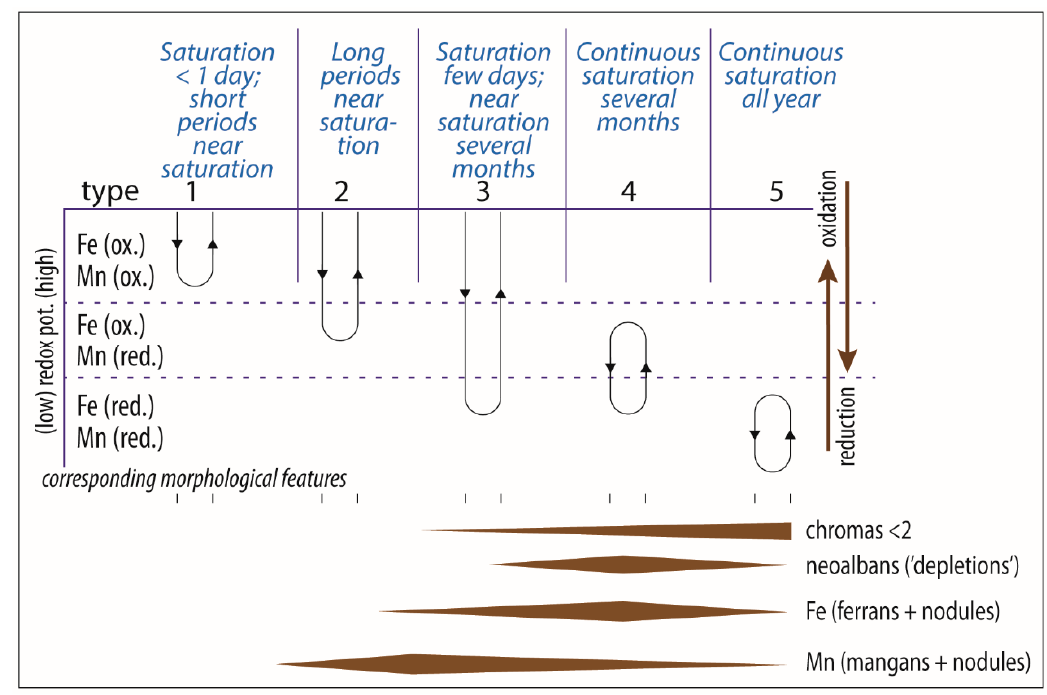
Figure 9. Schematic diagram of approximate soil-moisture redox conditions (potential) and resulting redox (or redoximorphic) features and different associated soil types designated 1–5. The Kainui soil’s redox features, such as at Swallow Lane and Gordonton Road, would place it normally between types 2 and 3. Pot., potential; ox., oxidized; red., reduced. Redrawn after [168] (p. 135), following [169] (p. 273), with permission of the publisher. Note that slightly different terms are used regarding soil redox features in New Zealand (NZ) [11,46,163] and the United States (USA) [47], with some approximately equivalent terms as follows: redox segregations (NZ) = redox concentrations (USA); low chroma colours (in matrix or on ped faces) (NZ) = redox depletions (USA); low chroma matrix or reductimorphic horizon (NZ) = reduced matrix (USA); redox-mottled horizon (NZ) = redoximorphic features (USA).